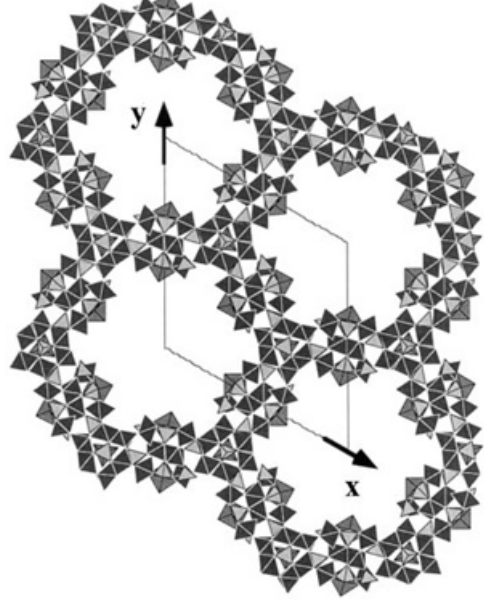
Figure 1: Projection of three-dimensional open structure of iron phosphate